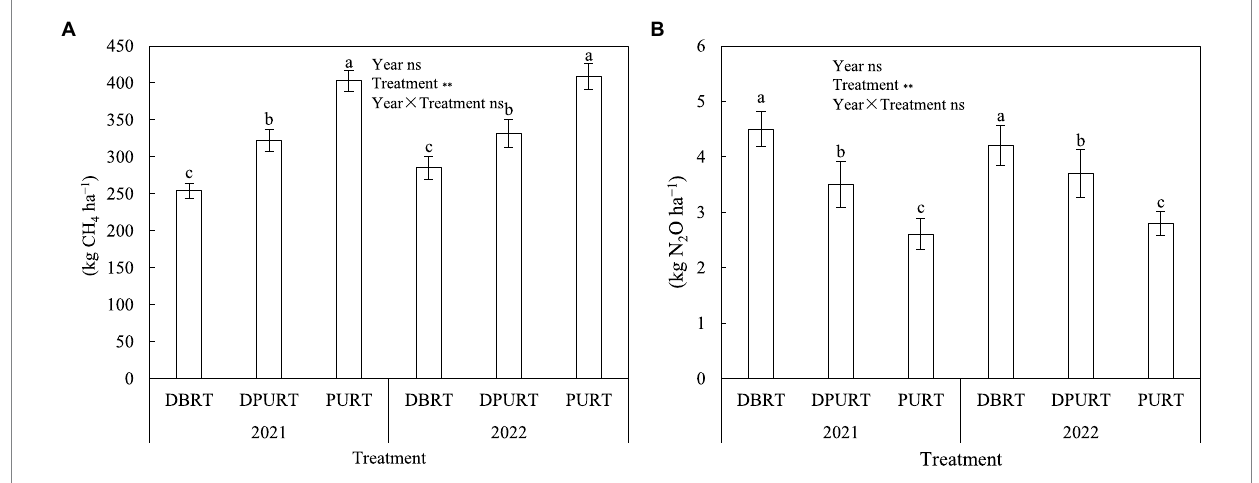
FIGURE 2 Cumulative soil CH 4 (A) and N 2 O (B) emissions in the three tillage treatments in 2021 and 2022. DBRT, dryland biaxial rotary tillage; DPURT, dryland and paddy field uniaxial rotary tillage; and PURT, paddy field uniaxial rotary tillage. Data for 2022 were presented as the average of the two varieties. Vertical bars are mean ± standard error (n = 4). NS, not statistical significance ( p > 0.05); **, statistical significance ( p < 0.01). Different lowercase letters after the data in the table indicate statistically significance within the same column and the same year ( p < 0.05).